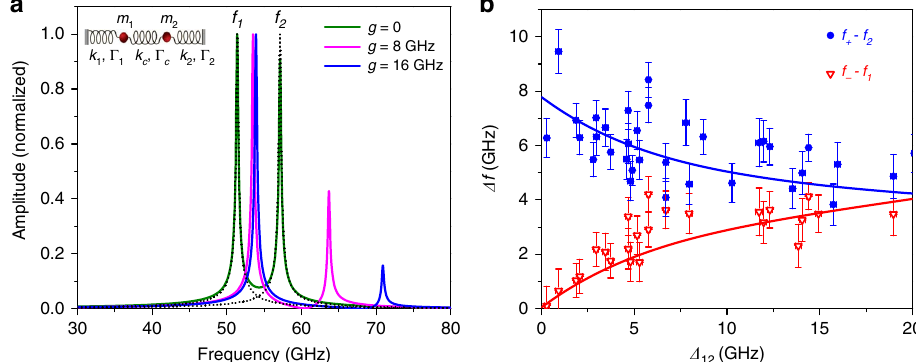
Fig. 4 Simulations of mechanical coupling between resonators. a Calculated vibrational spectra with different coupling rates. The inset shows the schematic model of coupled resonators. b Frequency shift of the higher f + and lower f − modes versus frequency detuning Δ 12 ¼ f 2 (cid:2) f 1 . The symbols are experimental results with standard deviations of 1.1% and the lines are calculated frequency shifts for the coupling rate g = 7.5